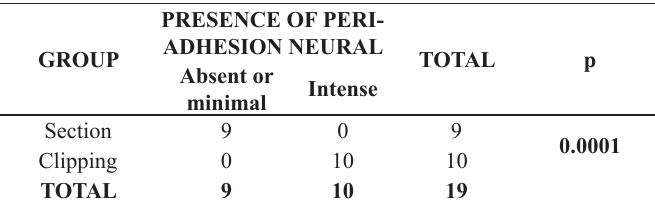
TABLE 1 - Presence of peri-neural adhesion between the groups section and clipping.